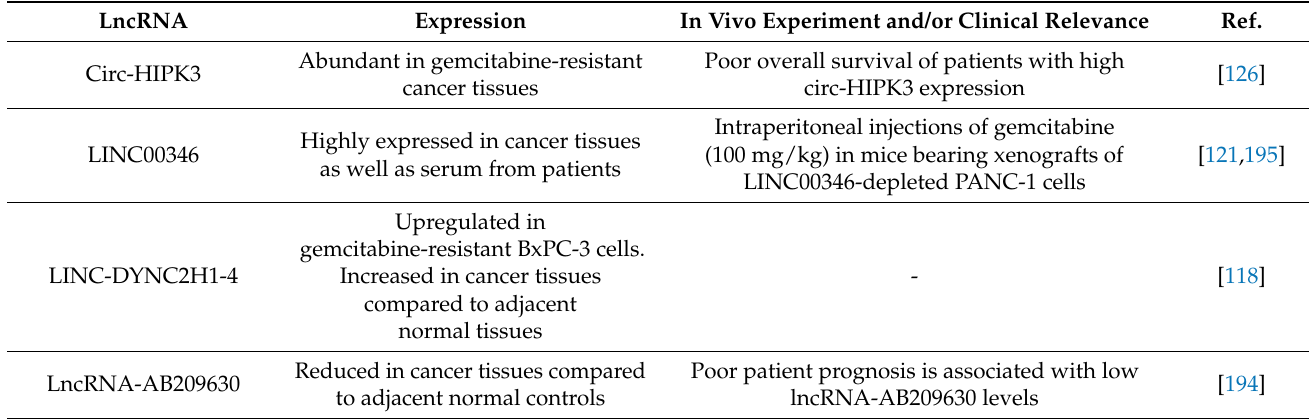
Figure 3. CircRNA- and lncRNA-mediated regulation of therapeutic resistance in PaC. Tumor-suppressive lncRNAs in rounded rectangles are shown in blue. Oncogenic circRNA and lncRNA are indicated in red within rounded rectangles. Round brackets denote miRNAs, the signaling pathway, or a protein molecule affected by ncRNAs and then therapeutic agents influenced by ncRNAs. Activation is indicated by an arrow. Inhibition is denoted by a perpendicular line. GEM: gemcitabine; 5-FU: 5-fluorouracil; CIS: cisplatin. Table 3. CircRNA, lncRNA, and therapeutic resistance in PaC.